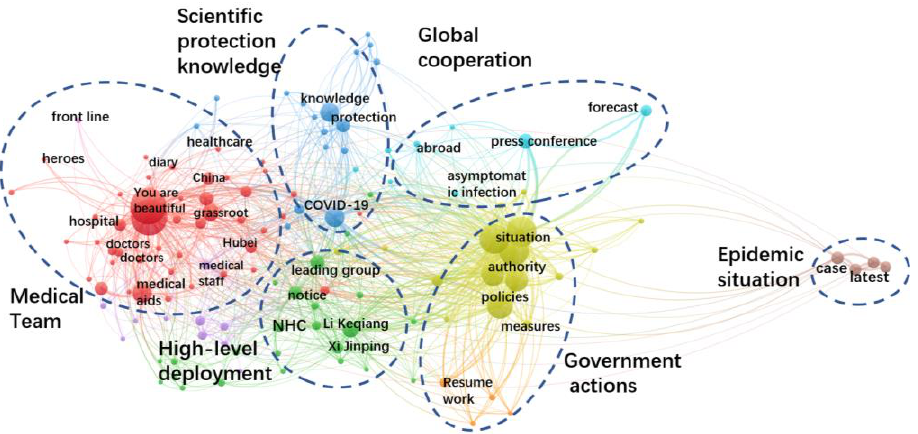
Figure 9. Keywords co-occurrence network of government information supply in the stable stage.